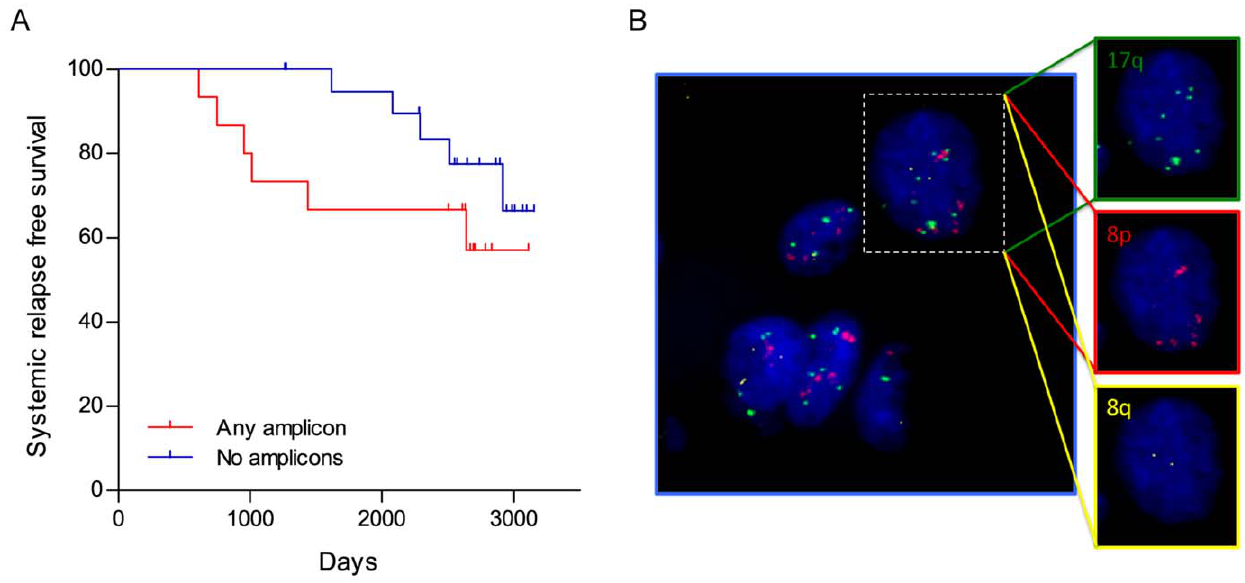
Figure 4. Analysis of amplicon status using multiplexed FISH in a cohort of tamoxifen treated ER + /HER2- breast cancers. ER + /HER2- samples with systemic relapse events were probed for the amplification of 8p11.2, 17q22 and 8q24.3 by multiplexed FISH assay as described